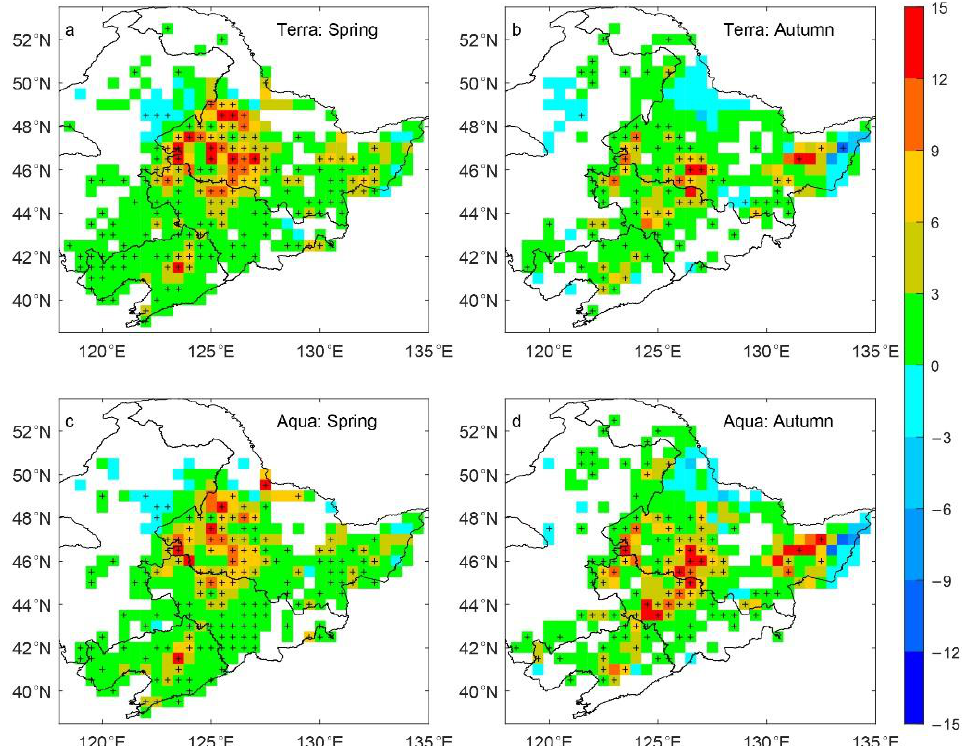
Figure 4. Long-term trends in fire counts (units: spots per year) in ( a , c ) spring and ( b , d ) autumn in Northeastern China during 2003–2018 from ( a , b ) Terra and ( c , d ) Aqua fire products. The “+” sign indicates that the trend passed the significance test at the 5% level.